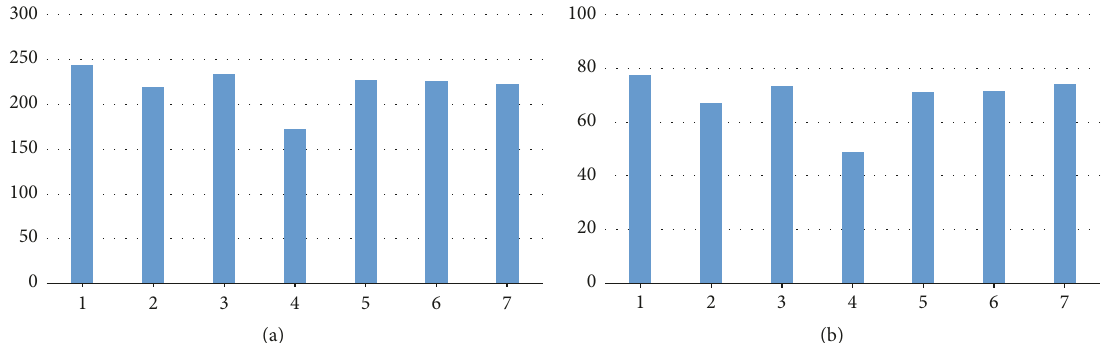
Figure 21: The final total results: (a) the number of accepted images (passing the image filtration process of the four parameters); (b) percentage